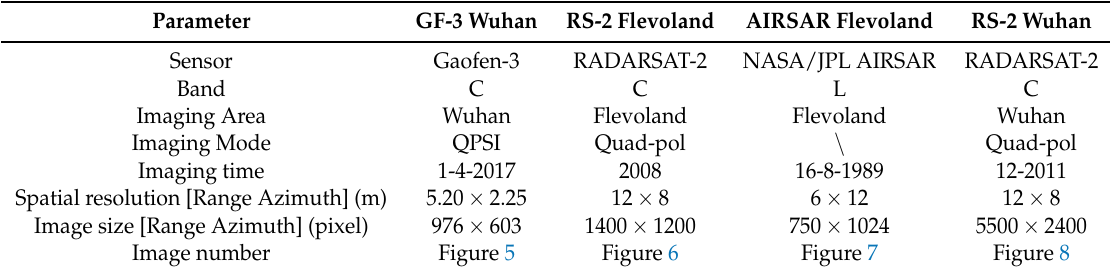
Table 1. The detailed information of four real PolSAR datasets.